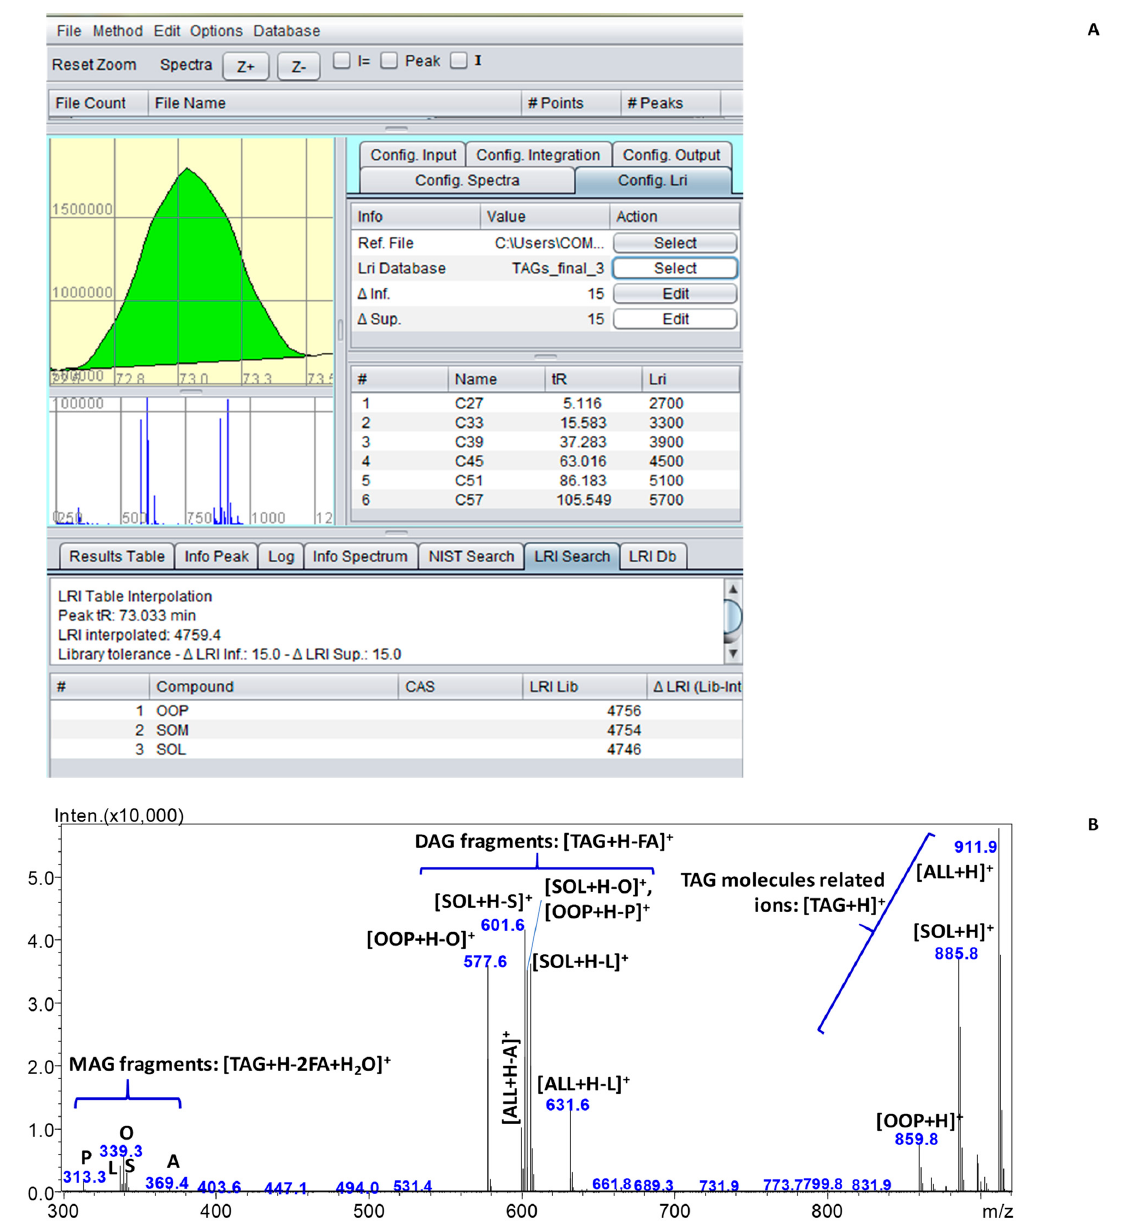
Figure 4. ( A ) Automatic search in the LRI database for peak at 73.03 min and ( B ) relative MS spectra with the assignment of MS signals.